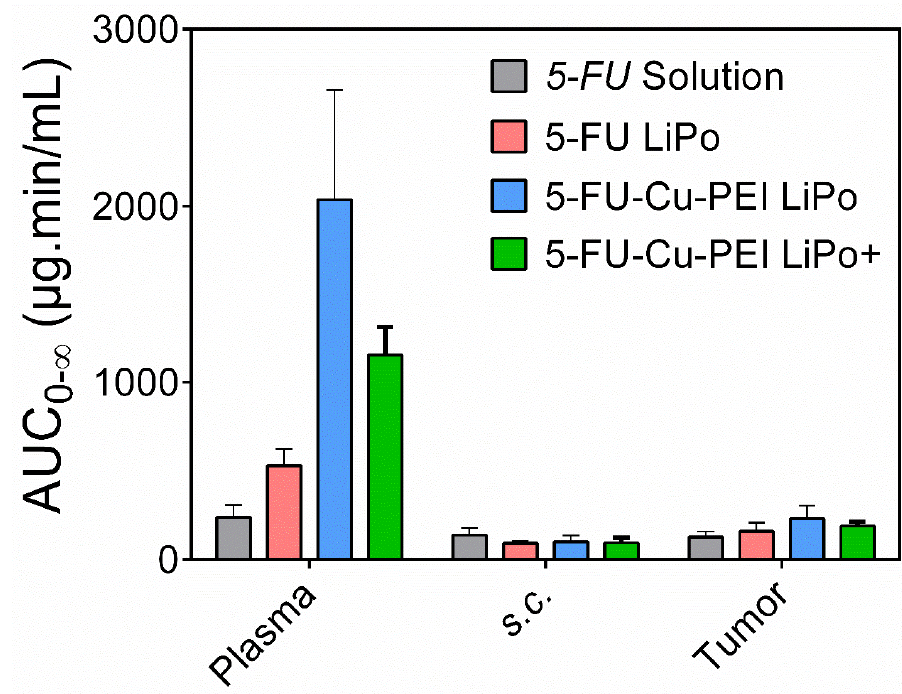
Figure 4. AUC of 5-FU in plasma and the ECF of healthy s.c. tissue and tumor tissue following i.v. administration of various 5-FU formulations (10 mg/kg). Data represent mean ± S.D. ( n ≥ 5).